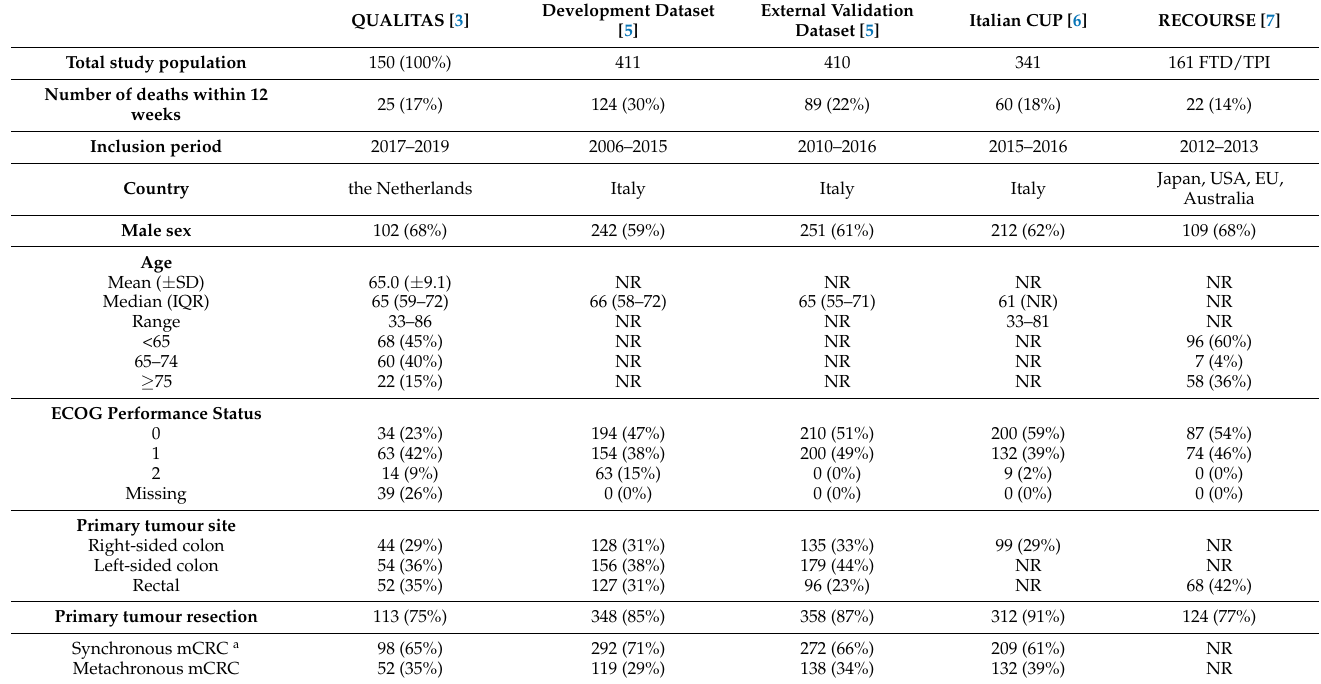
Table 1. Characteristics of the QUALITAS study patients compared to development and external validation cohort